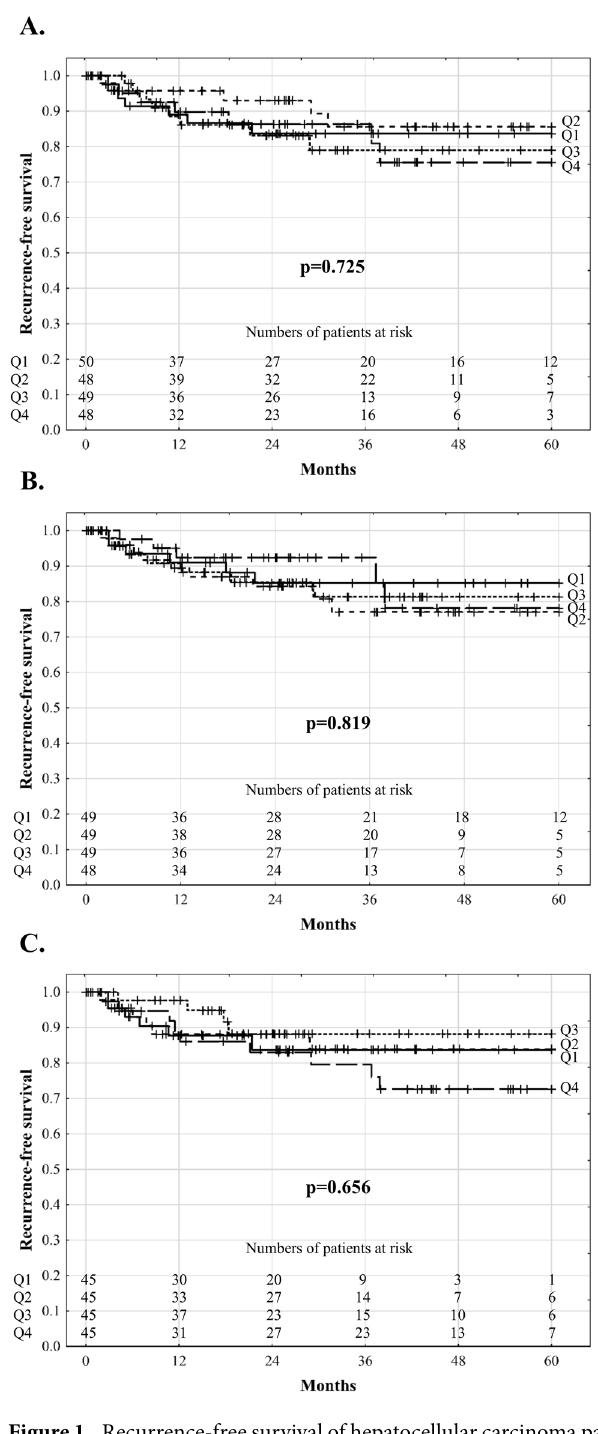
Figure 1. Recurrence-free survival of hepatocellular carcinoma patients after liver transplantation according to quartiles of aspartate transaminase ( A ), alanine transaminase ( B ), and lactate dehydrogenase ( C ) activity 2 hours after portal